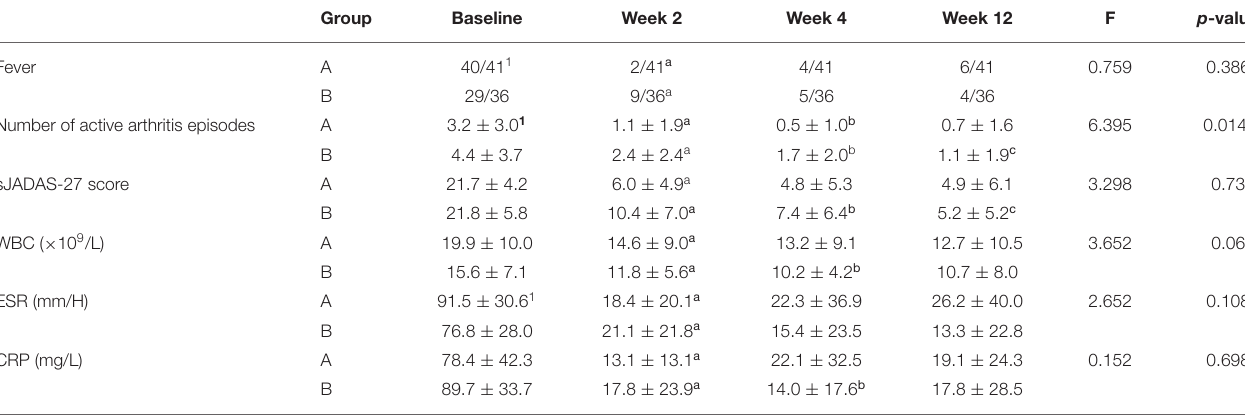
TABLE 2 | Changes in clinical parameters after tocilizumab treatment in children with systemic juvenile idiopathic arthritis. Group Baseline Week 2 Week 4 Week 12 F p -value